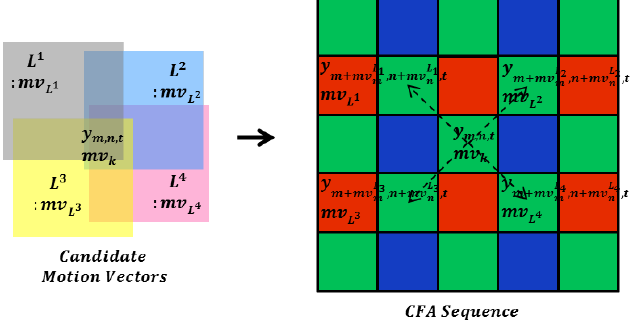
Figure 7. Illustrations of the motion-compensated prediction.